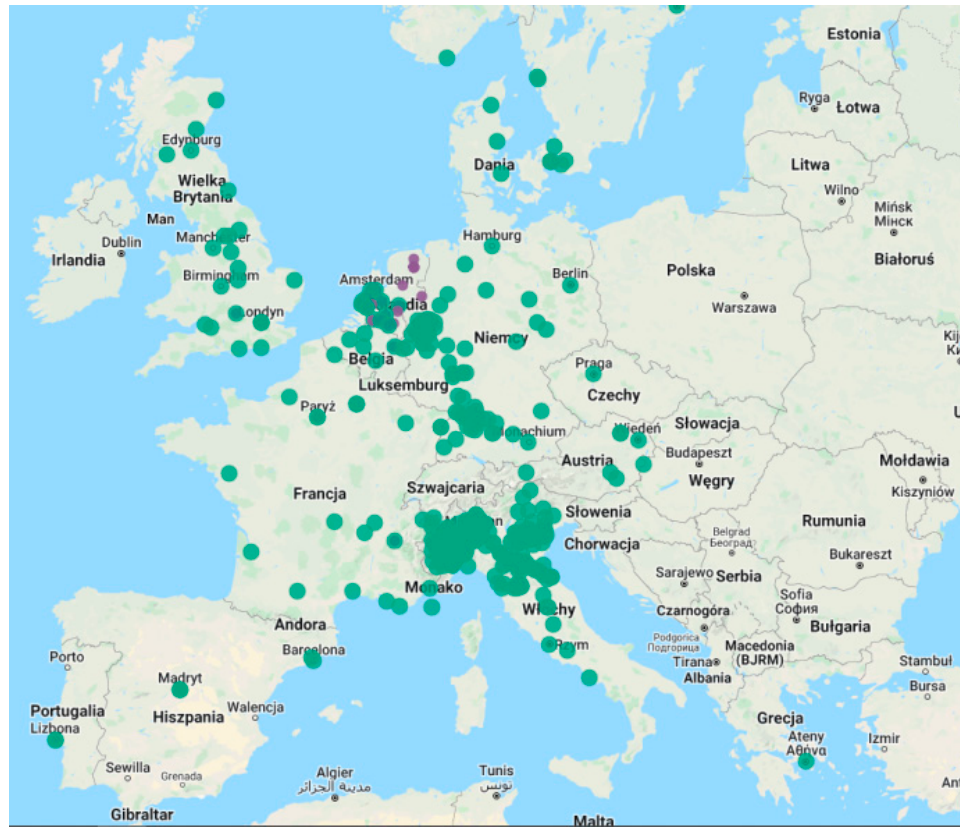
Figure 10. Zero- and low-emission zones within the European Union, 2022 [19].